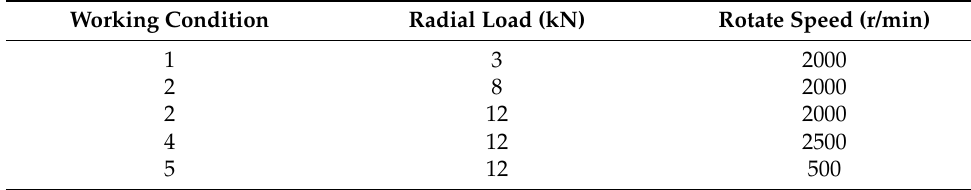
Table 2. Operating parameters of cylindrical roller